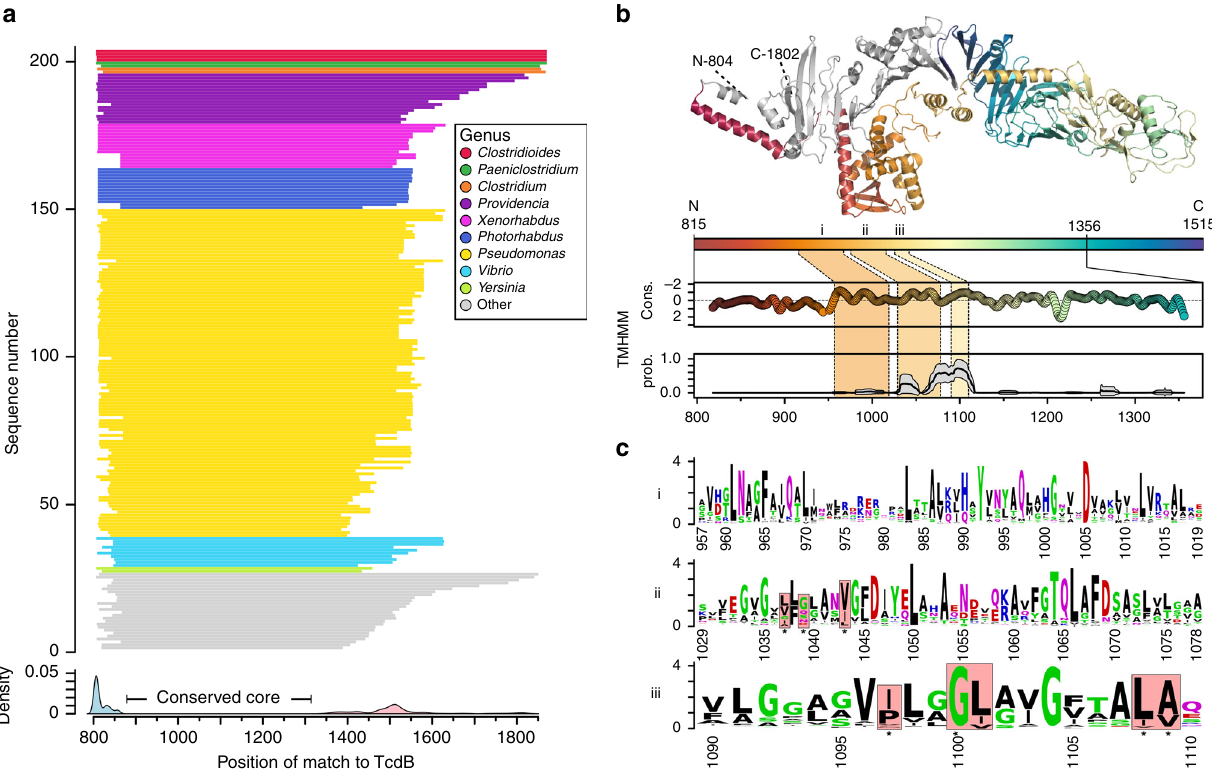
Fig. 4 Patterns in sequence conservation among LCT-like T-domains. a The distribution of BLAST matches to the TcdB T-domain demonstrates that the region common to all LCT-like T-domains is limited to within the fi rst 700 amino acids of the N terminus. b The structural context of the mean BLAST start (815) and end (1515) sites, as mapped on to the TcdA T-domain (PDB 4R04). Normalized sequence conservation for the region spanning residues 815 to 1356 shows three main peaks of sequence conservation (i, ii, and iii). Two of these conserved regions correspond to an average increase in predicted transmembrane helix propensity. c Within the three sequence conservation peaks, several sites known to result in the loss of translocation activity in TcdB are conserved among LCT-like T-domains. However, several strongly conserved residues are not associated with a loss of translocation function, suggesting they are related to some other key function in LCT-like